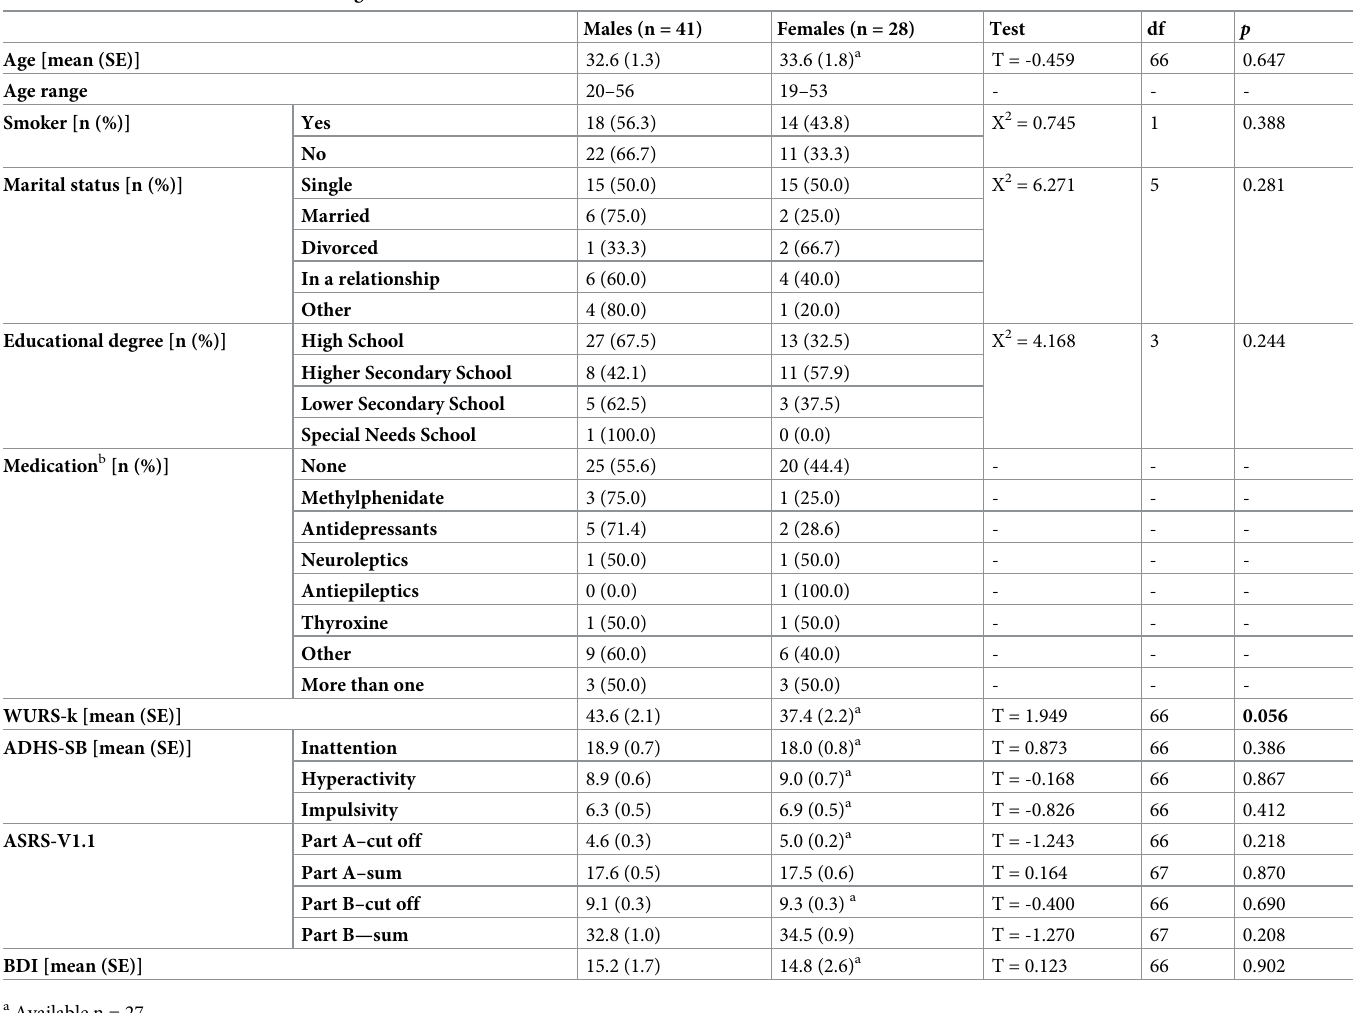
Table 1. Basic characteristics and screening scale results for females and males with